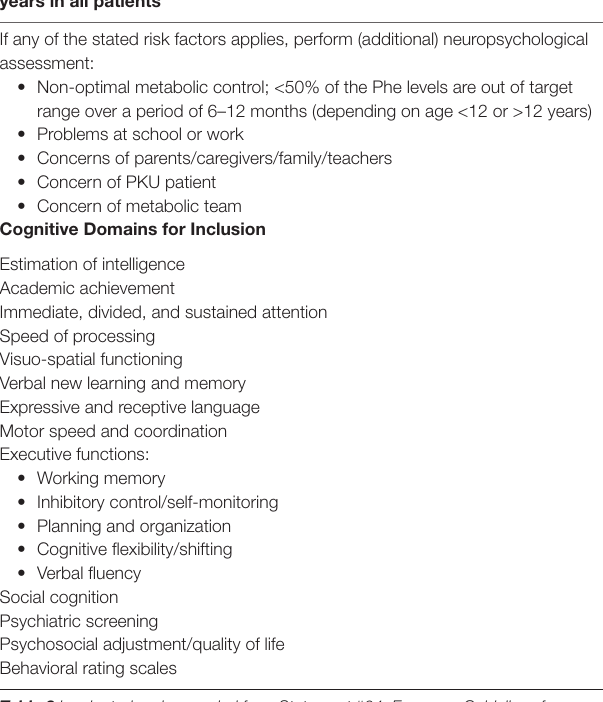
TABLE 2 | Neuropsychological assessment